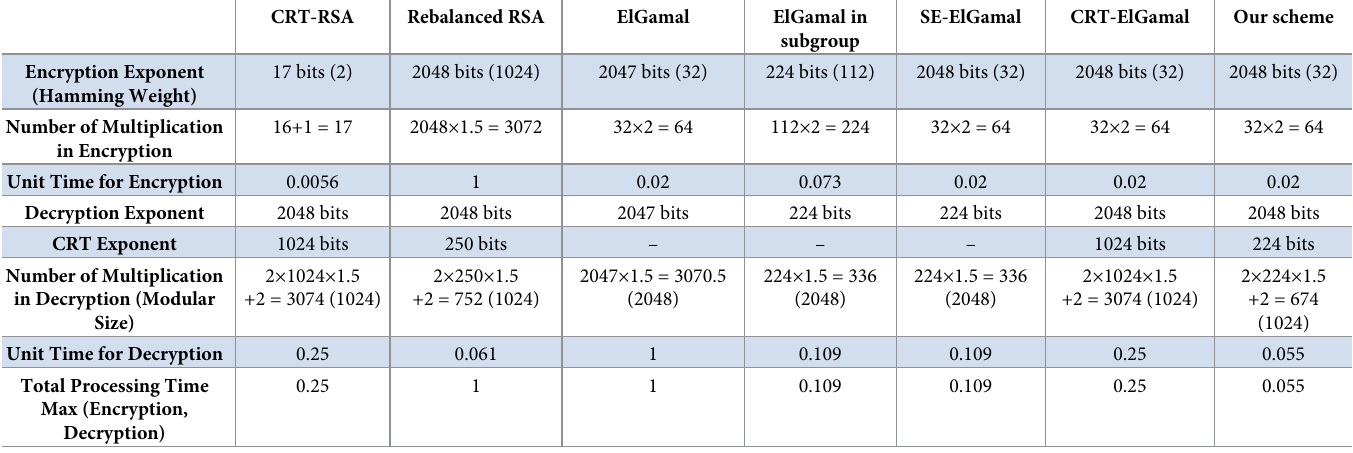
Table 1. Theoretical encryption and decryption time